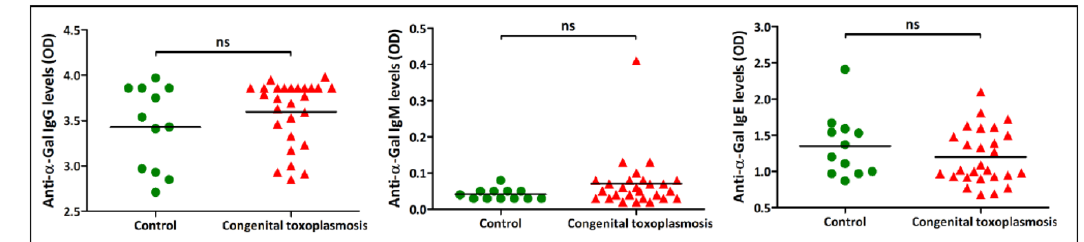
Figure 6. Reactivity of IgG, IgM, and IgE antibodies to α -Gal in newborns with congenital toxoplasmosis as assessed by indirect ELISA. Mann–Whitney U test: ns—not